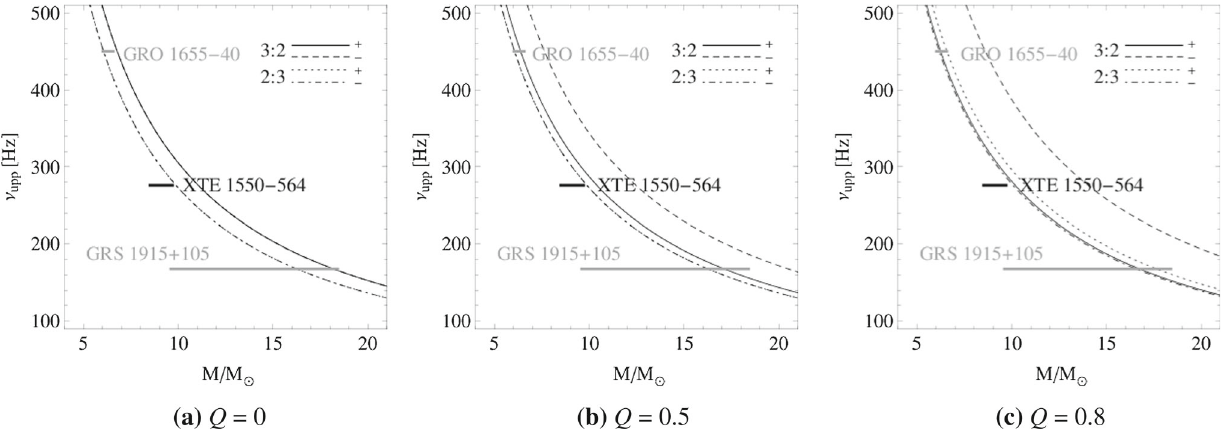
Fig. 10 The upper frequency ν U of string loop oscillations at 3:2 or 2:3 resonant radii, calculated in the framework of the string loop model with maximal range string loop parameter ω as a function of black hole mass for several values of the black hole charge Q = 0 , 0 . 5 , 0 .